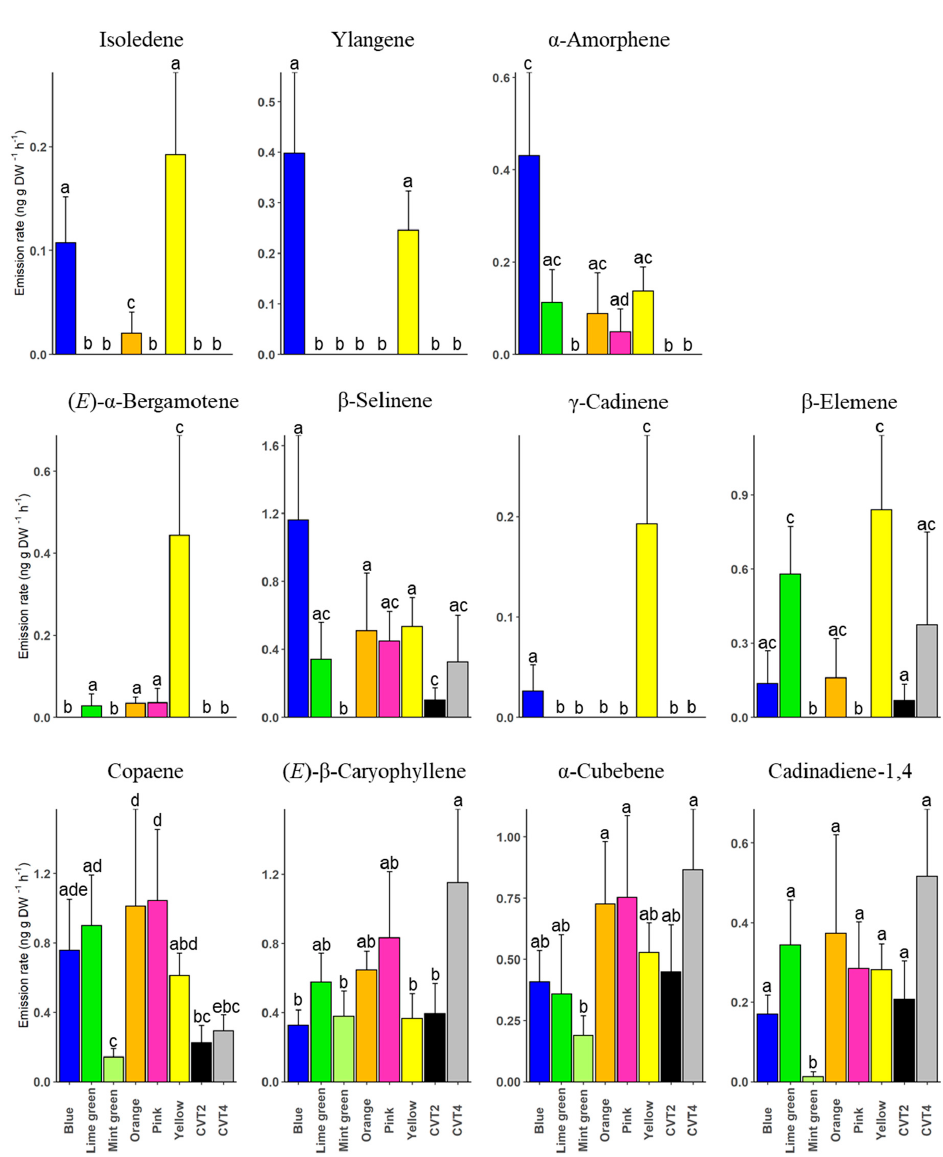
Figure 6. Emission rates for selected sesquiterpenes by different genotypes ( n = 5). Compounds were selected based on their VIP coefficients ( ≥ 1). A set of level contrasts was constructed using the “relevel” function in R. Bars show mean ± SE emissions, and different letters show significant differences between genotypes.